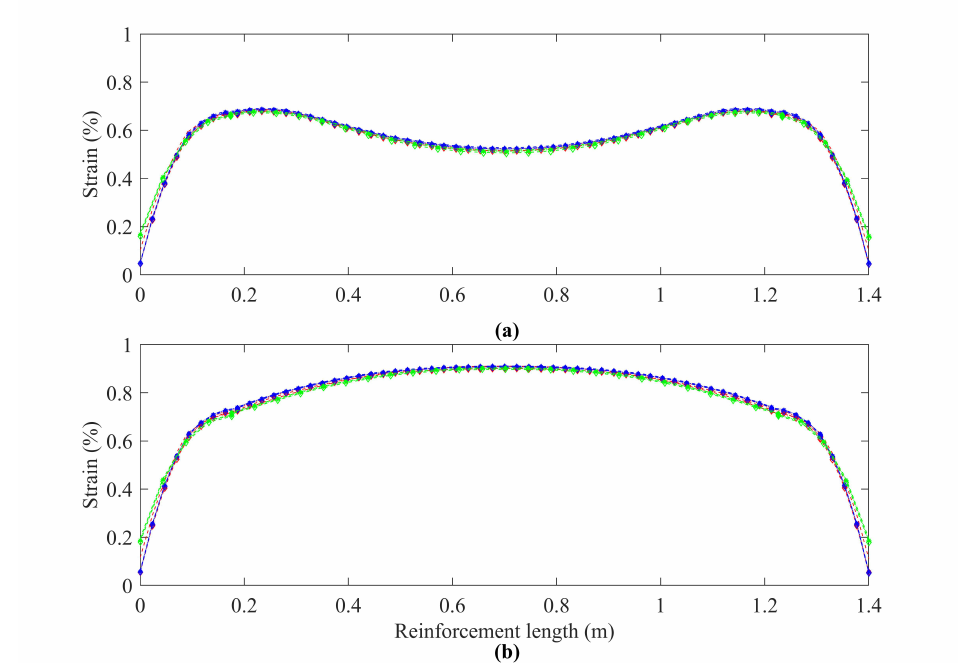
Figure 3. Effect of compaction procedures (Types-I, II, and III) on reinforcement strains of SGC mass, under p = 600 kPa and q of 10, 30, 44, 60 and 70 kPa—for reinforcements at depths: ( a ) 0.4 m; and ( b ) 1.2 m, from the specimen’s top